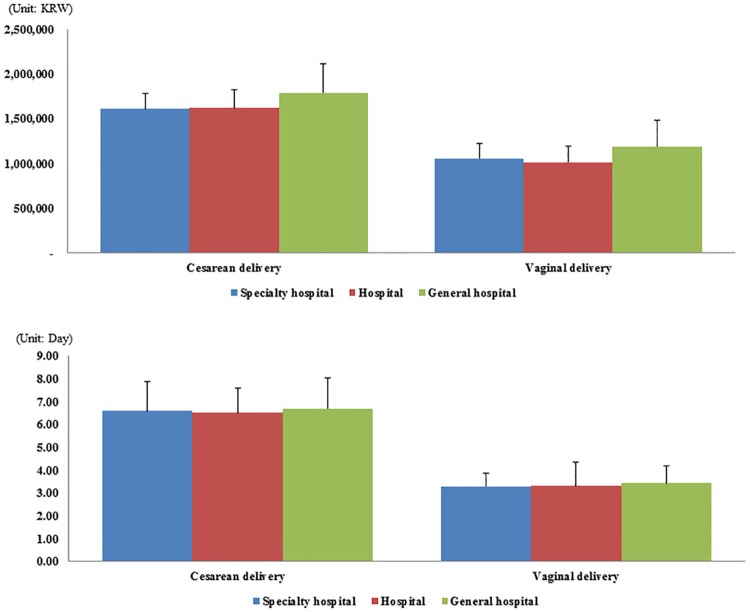
Differences in outcome variables between hospital type by Cesarean delivery and vaginal delivery.Data are shown as mean ± SD. All results are statistically significant by delivery type.